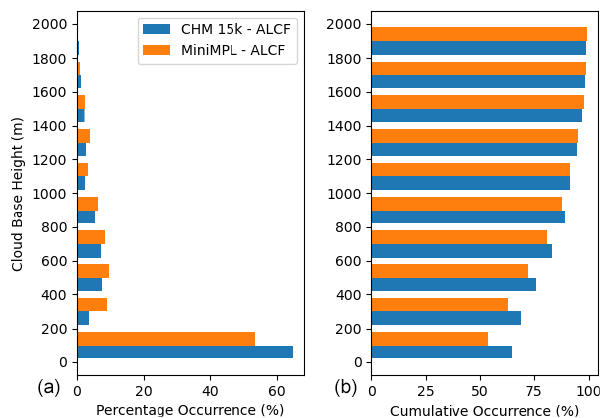
Figure 11. Histograms of cloud base height derived from the ceilometer and MiniMPL data processed by the ALCF software. The percentage occurrence (a) and cumulative occurrence (b) are shown for each 200m bin, from 0 to 2000m. Note that the near- surface percentages can be affected by the incomplete overlap of the lidar in the first few hundred